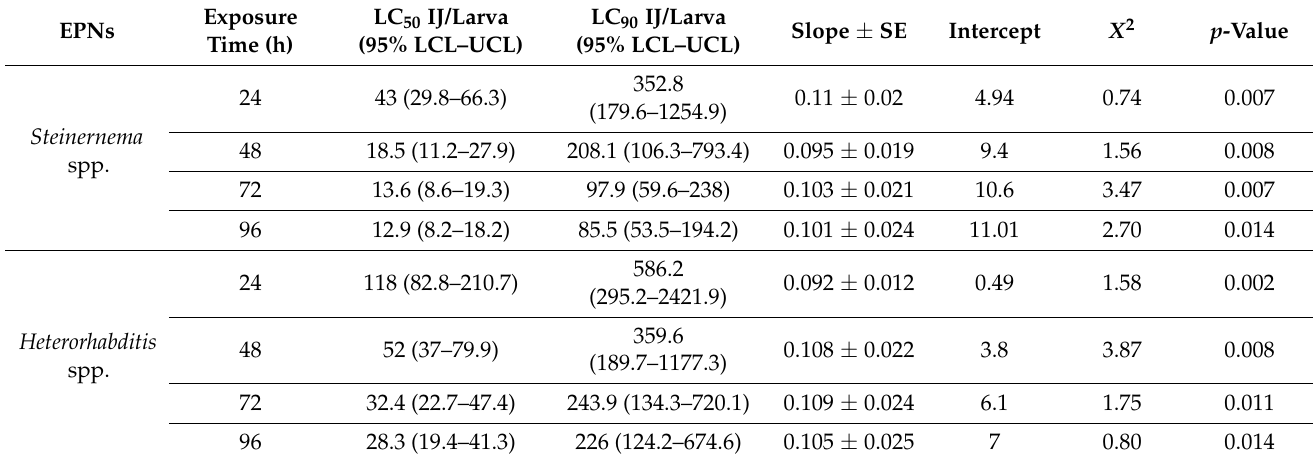
Table 3. Pathogenicity of two EPNs against the pomegranate butterfly, Virachola livia.